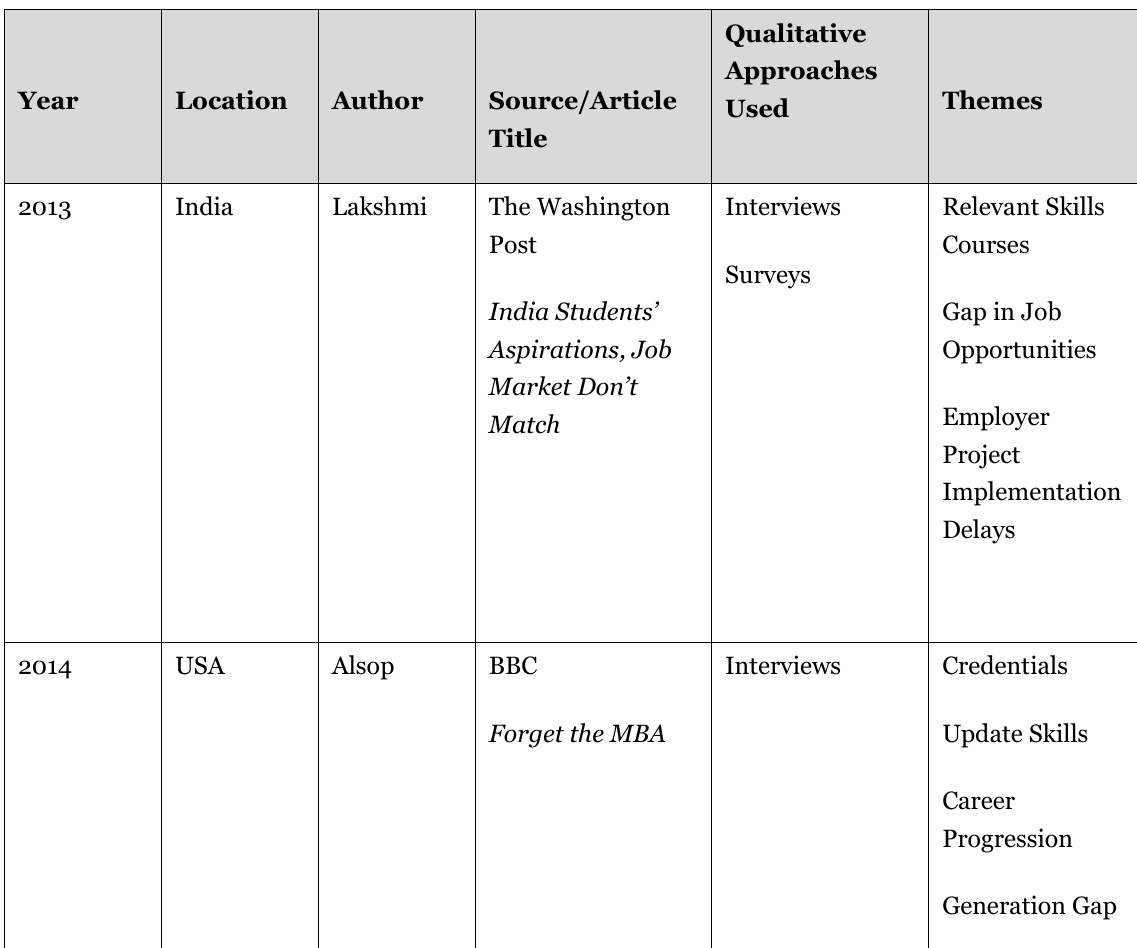
Qualitative Approaches Used Title